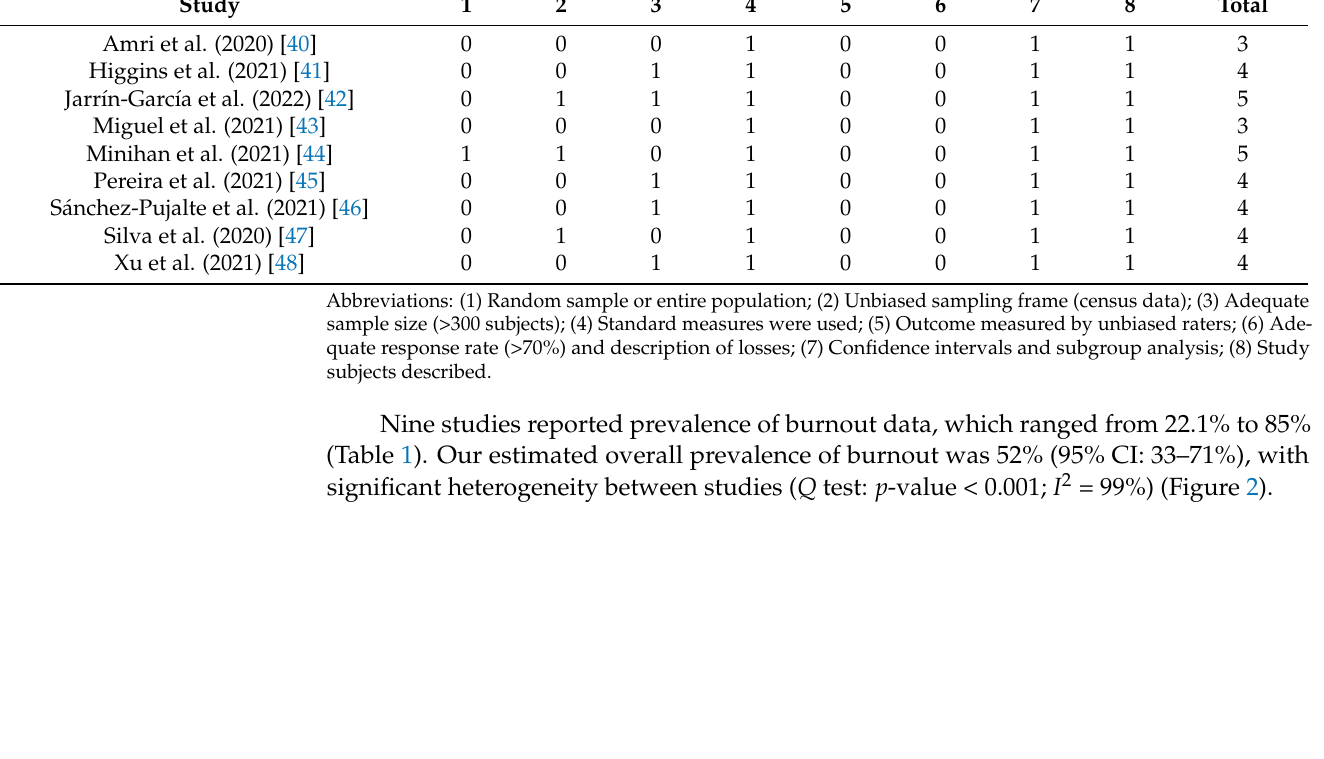
Table 2. Quality assessment.